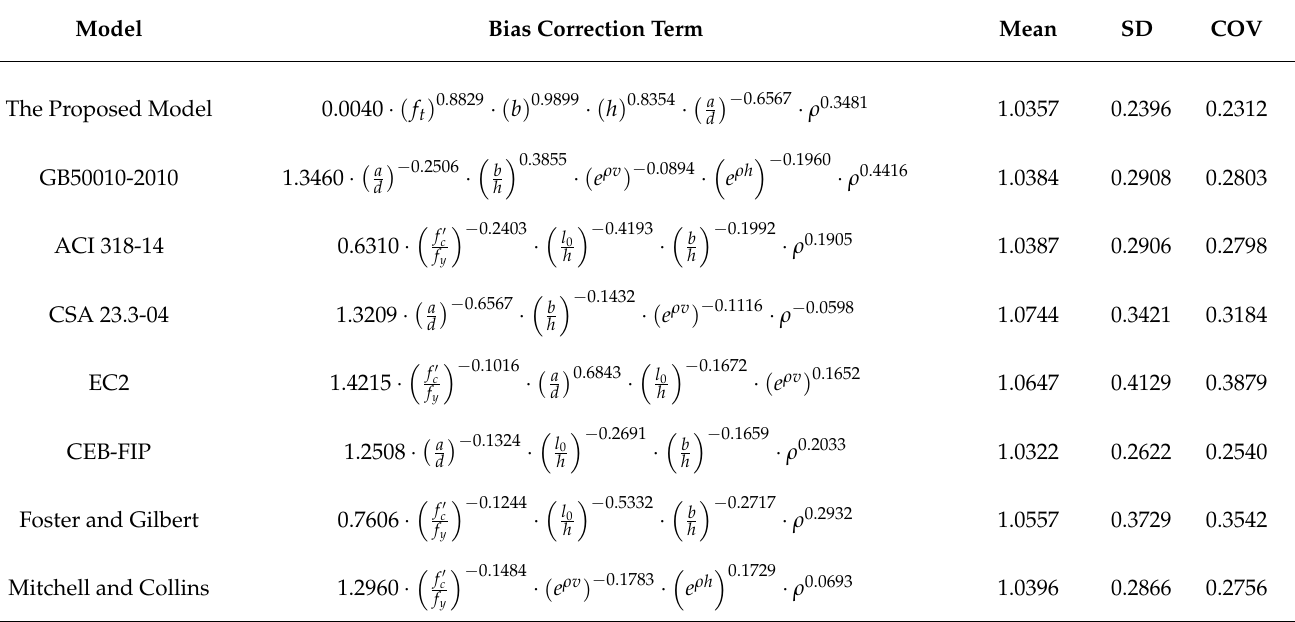
Table 6. Bias correction